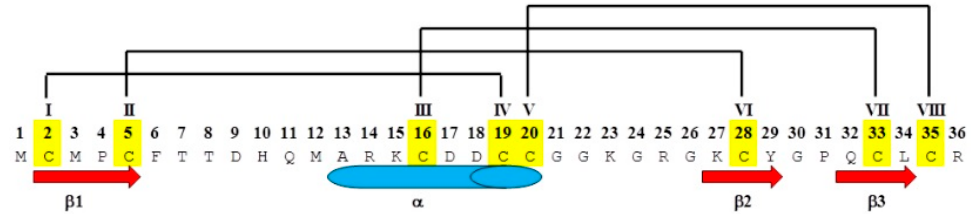
Figure 1. Amino acid sequence of Chlorotoxin (CTX), demonstrating the disulfide bond topology between Cys 2 –Cys 19 (I–IV), Cys 5 –Cys 28 (II–VI), Cys 16 –Cys 33 (III–VII), and Cys 20 –Cys 35 (V–VIII), shown as yellow with black brackets representing the associated disulfide bonds, and homology numbering shown as Roman numerals. The conserved secondary structural motifs of an α -helix from Ala 13 to Cys 20 , a β -sheet from Cys 2 to Cys 5 , and 2 antiparallel β -sheets from Lys 27 to Tyr 29 and Lys 32 to Leu 34 are shown as a blue cylinder and red arrows, respectively.